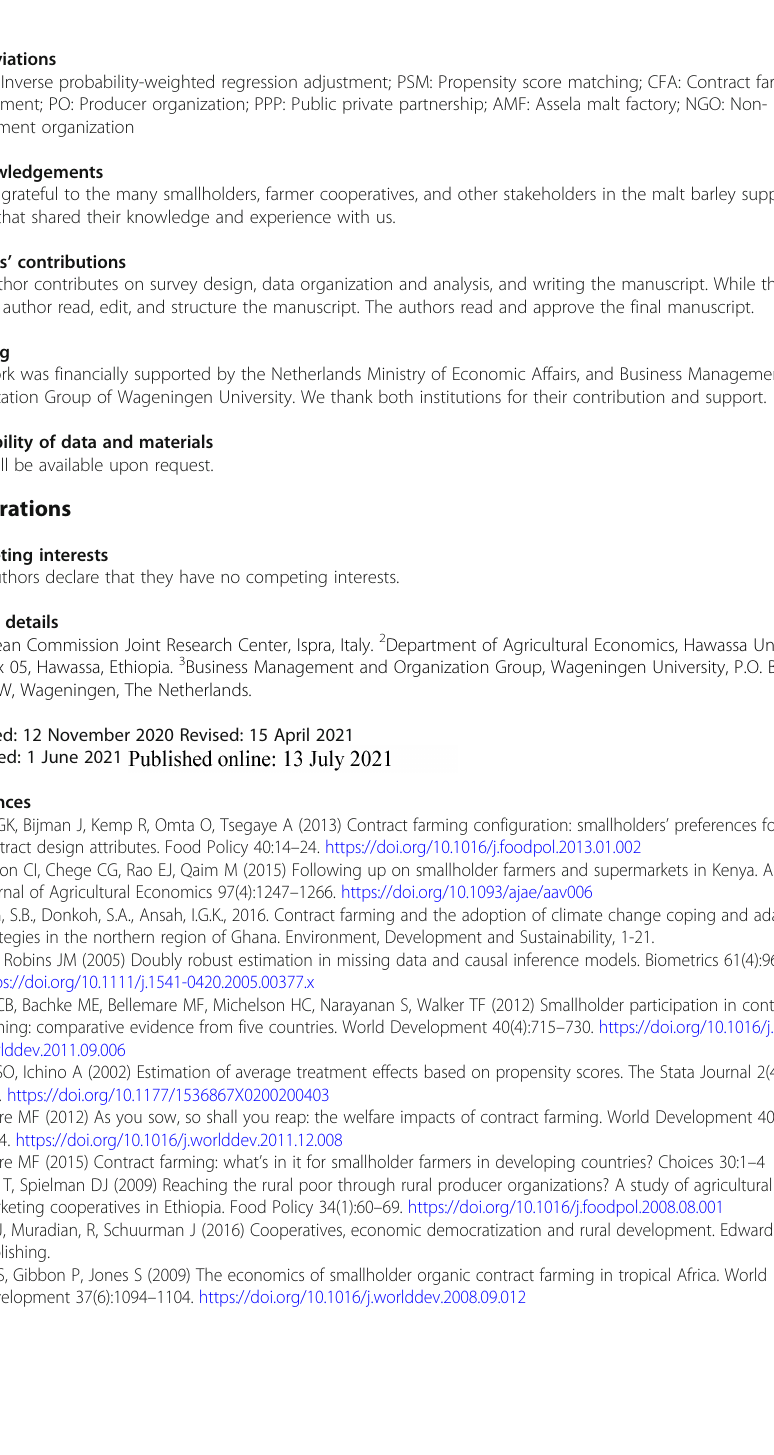
After matching (algorithms)